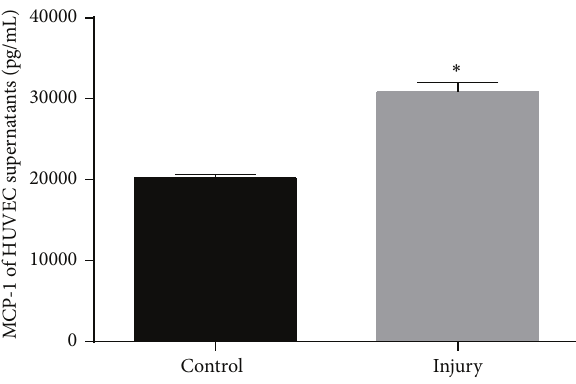
Figure 3: Effects of scratch injury on monocyte chemoattractant protein-1(MCP-1)concentrationsinhumanumbilicalveinendothe- lial cells (HUVECs) supernatants. ∗ 𝑃 < 0.05 compared with